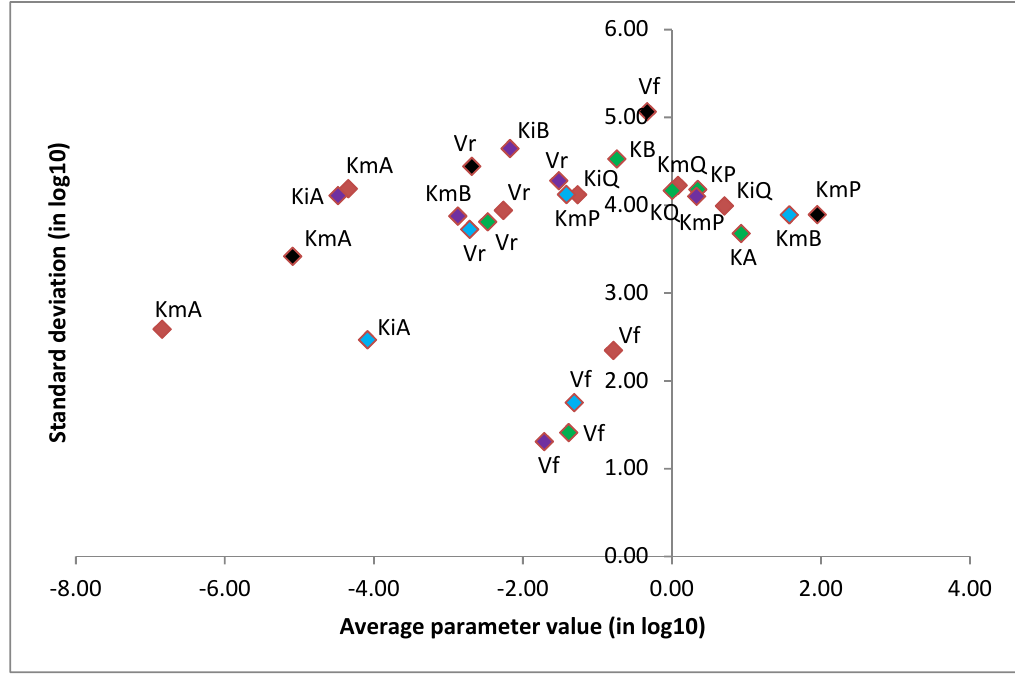
Figure 4. Average parameter values and standard deviations of estimated kinetic parameters after repeating the genetic algorithm 100 times. The parameters were classified into five reaction types: uni-uni (black), uni-bi (red), bi-uni (blue), bi-bi (purple) and convenience kinetics (green). Both axes of the graph are in logarithmic scale. Vf and Vr are the forward and backward reaction velocity, respectively; KmA , KmB , KmP and KmQ are Michaelis constants; KiA , KiB , KiP and KiQ are dissociation constants; KA , KB , KP and KQ are parameters of the convenience kinetics as defined in Equation (1).